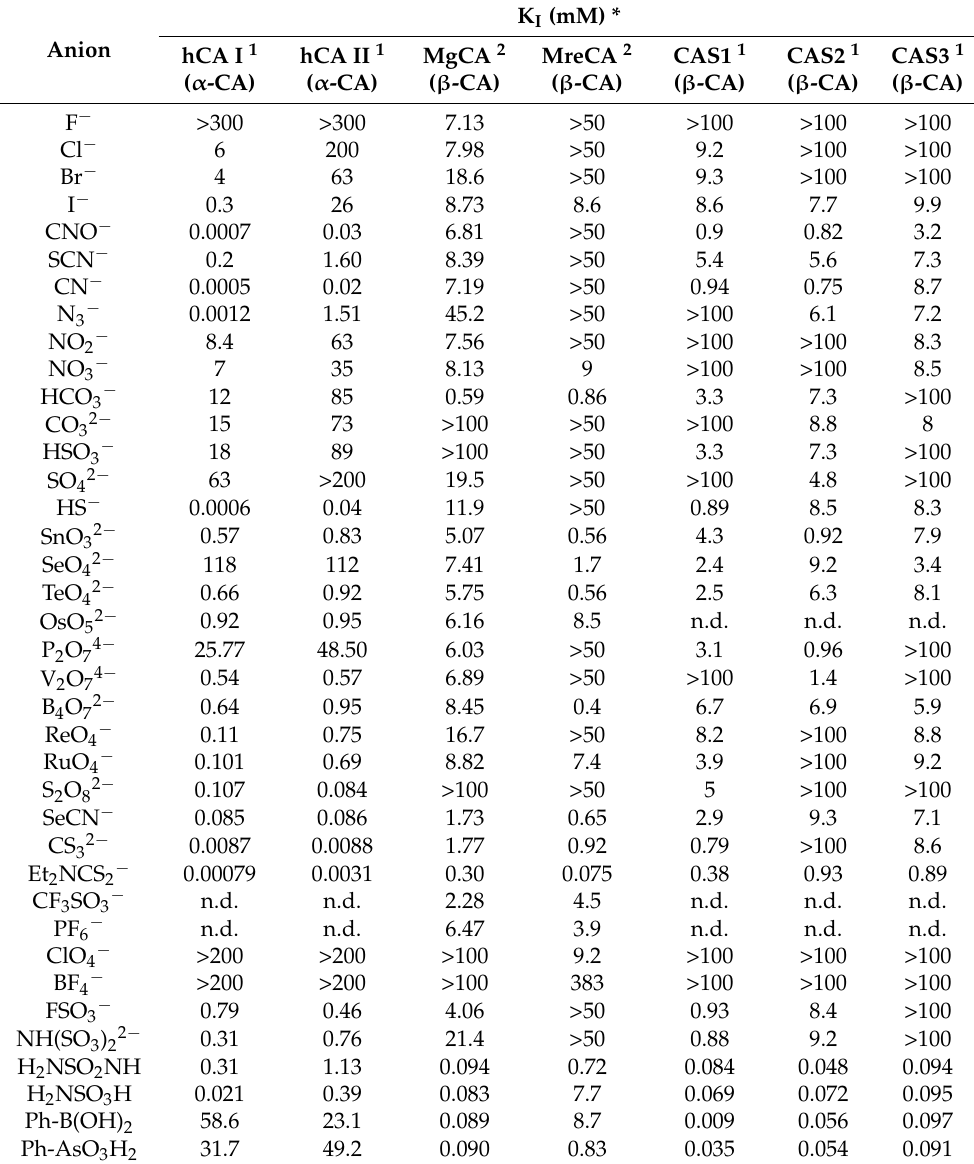
Table 2. Inhibition constants obtained using anionic inhibitors versus the α -CA isozymes of human origin (hCA I and hCA II), and Table 1. CAS2, CAS3; for the acronyms, see the text) by a stopped flow CO 2 hydrase